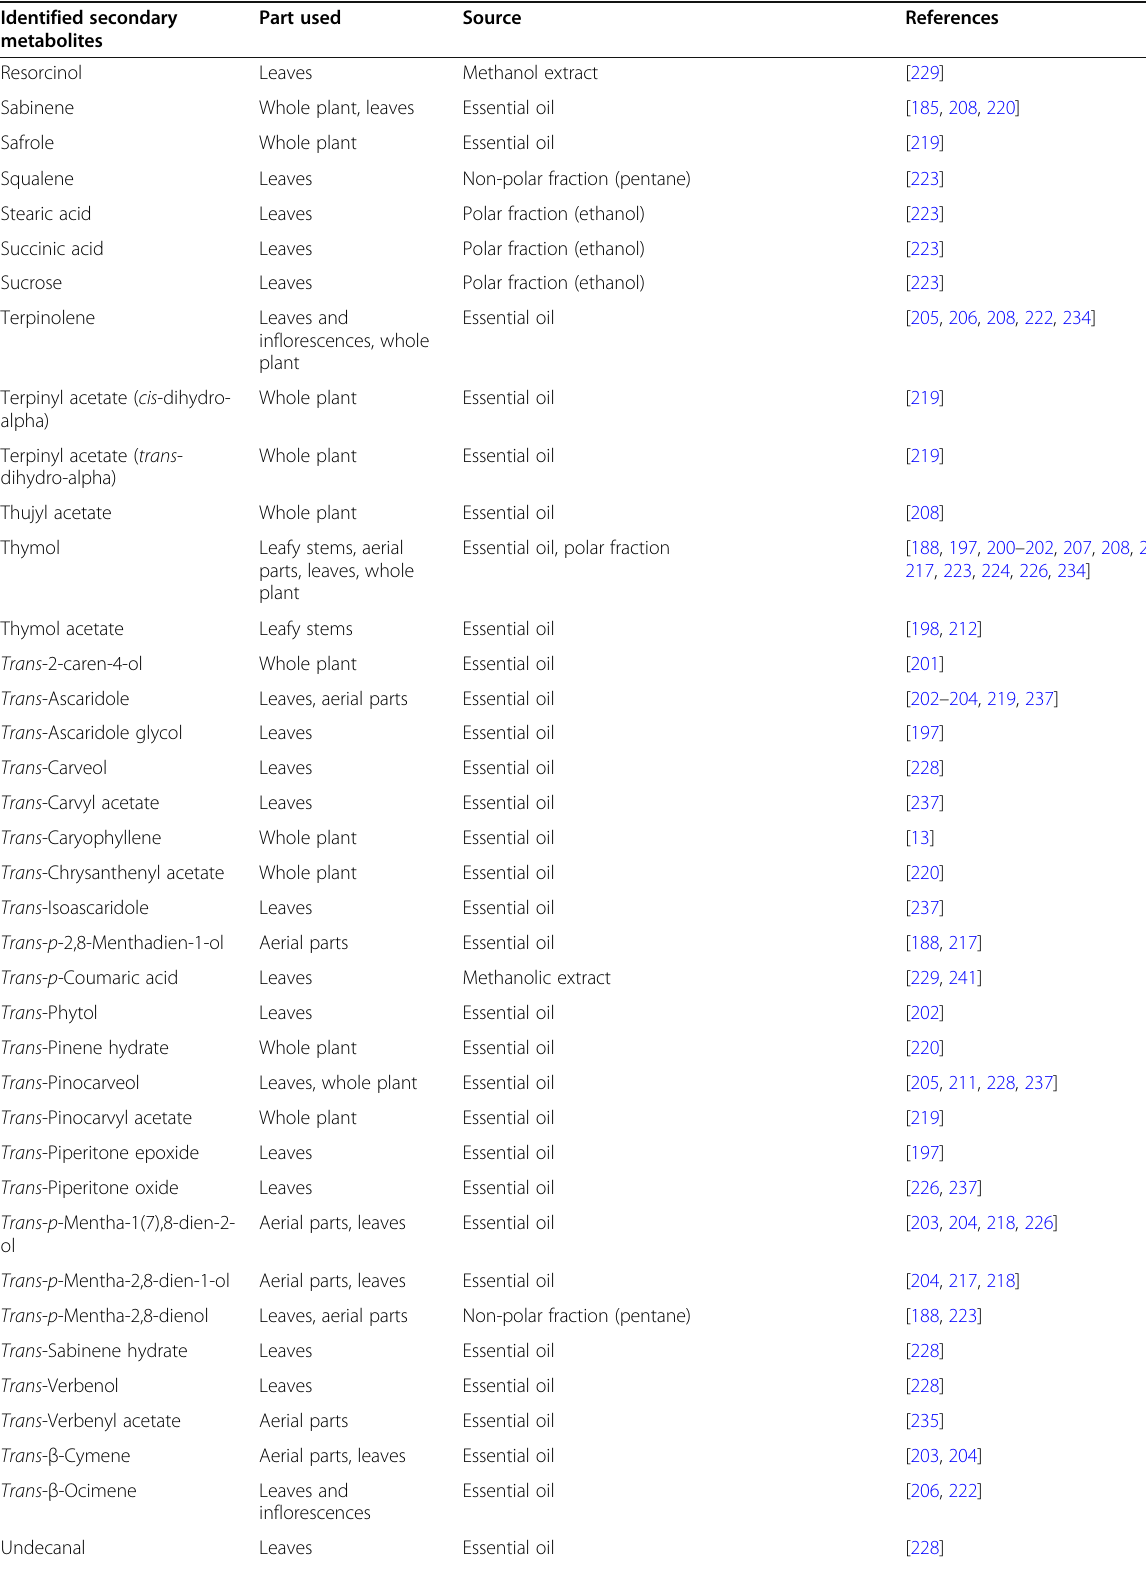
Table 3 Main secondary metabolites identified in C. ambrosioides